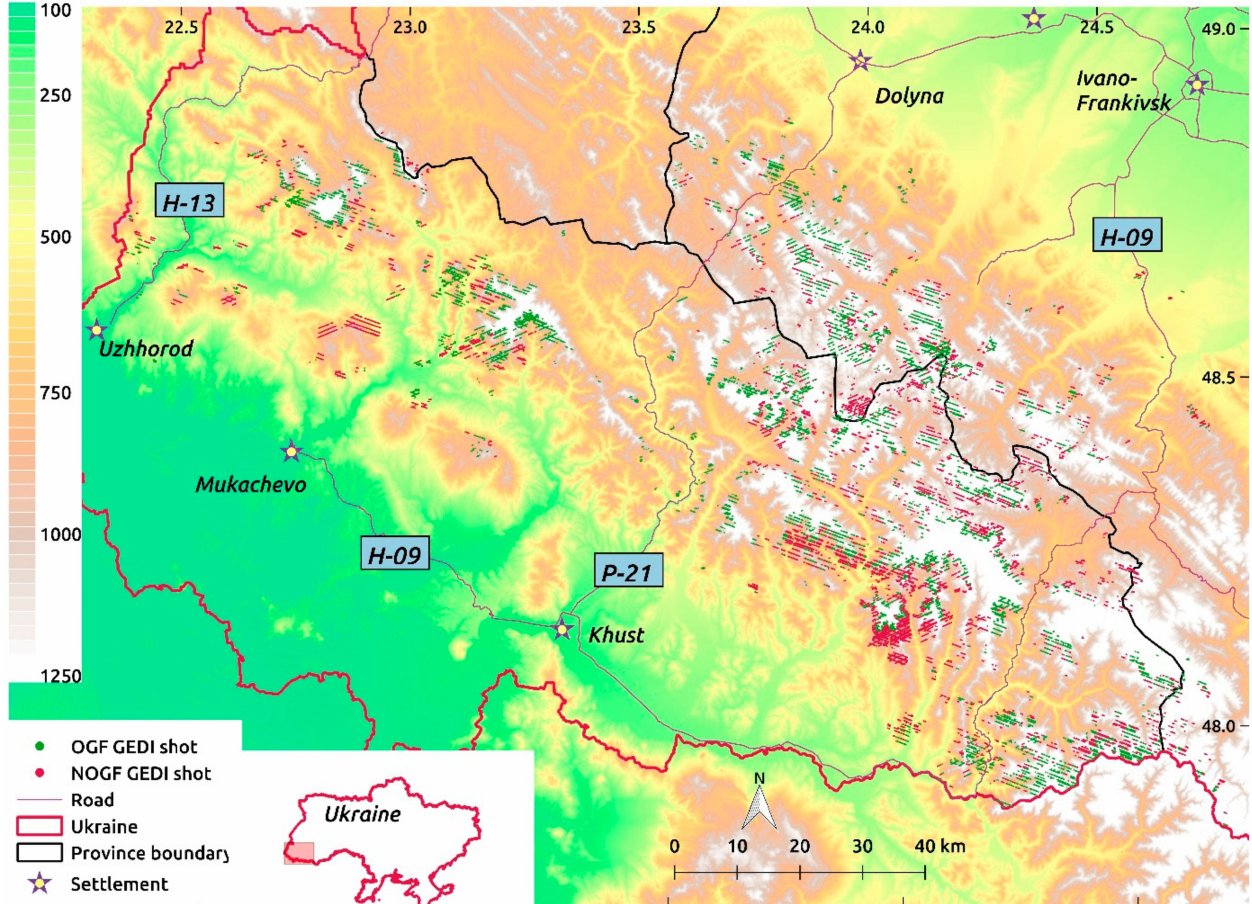
Figure 1. Map of study area showing the location of General Ecosystem and Development Investigation (GEDI) shots in old-growth forest (OGF) areas (green) and Non-OGF areas (red) that were used in this study. The inset map shows the location of the study area within